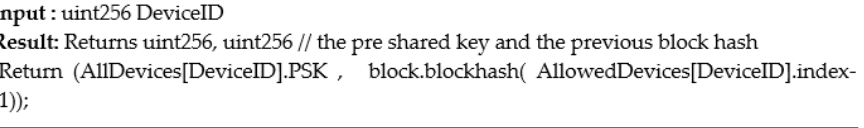
Figure 8 . GetAllTheInfo function